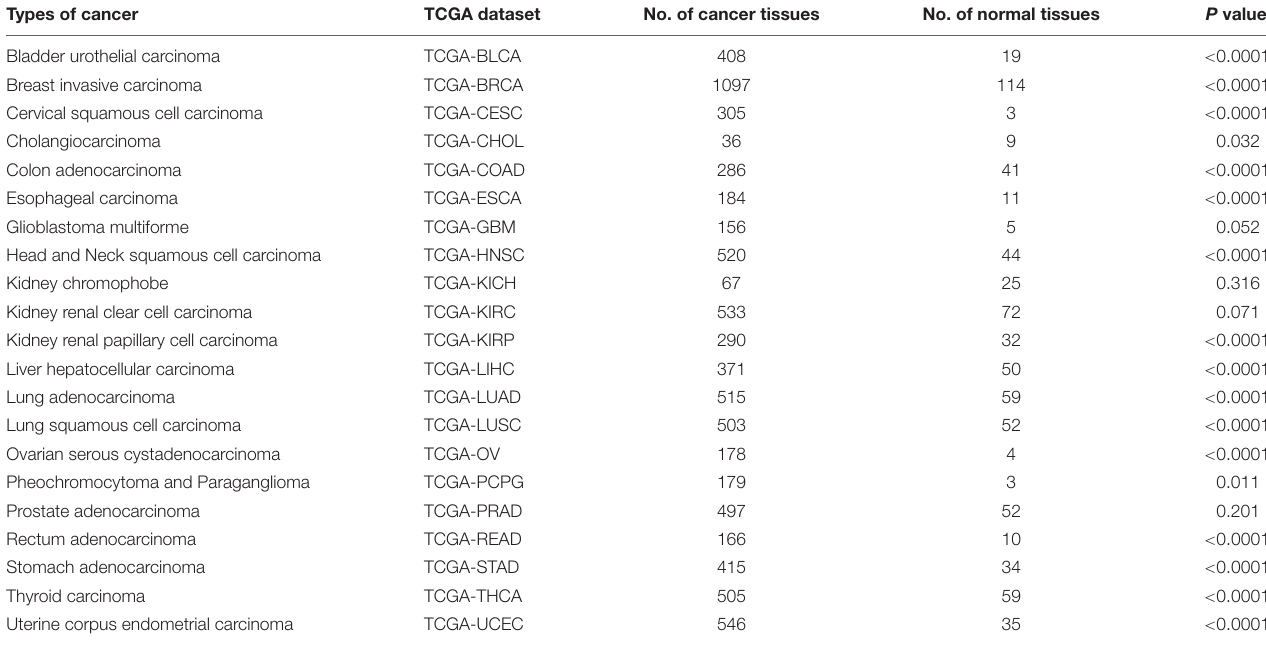
TABLE 4 | The difference of HMGA2 expression in cancers and corresponding normal tissues in TCGA datasets. Types of